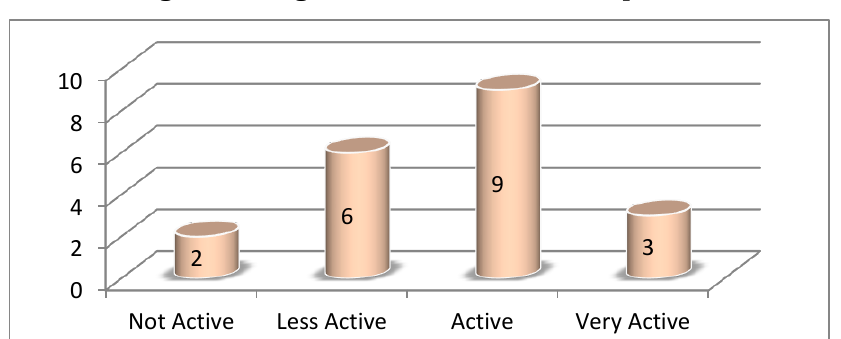
Figure 2. Diagram the Students'